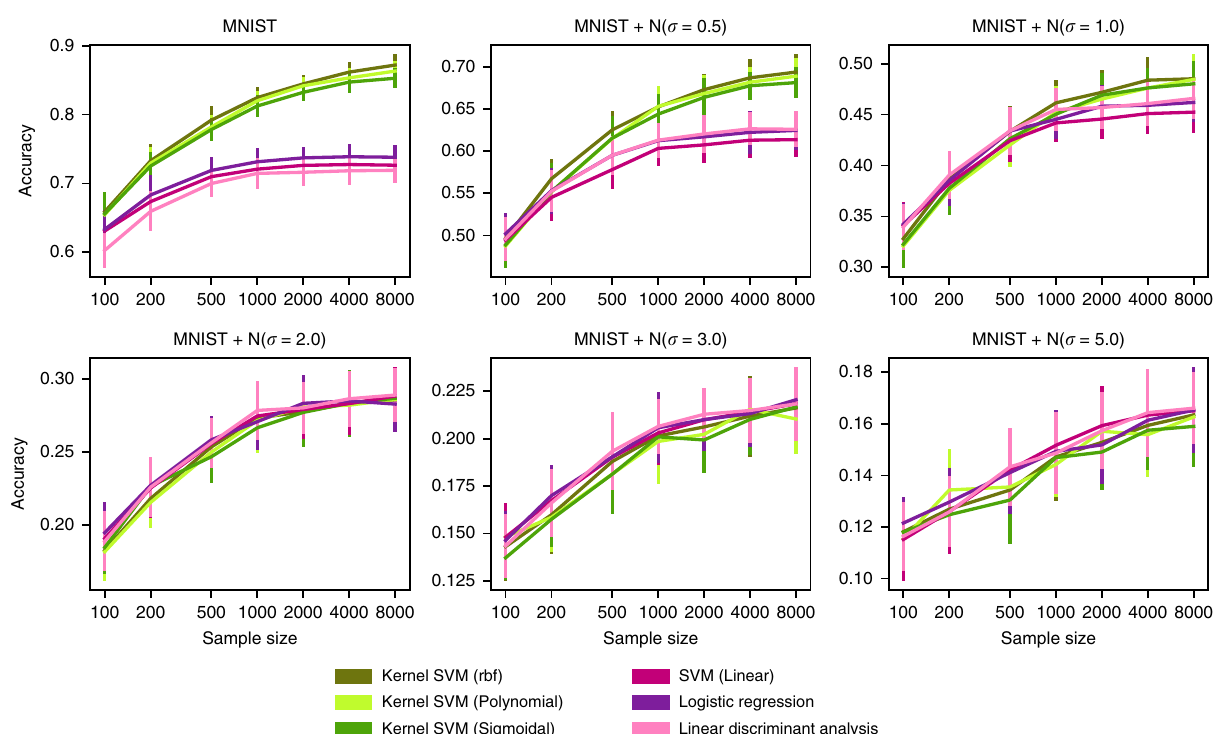
Fig. 6 Adding noise to MNIST images leads to scaling behavior similar to that of brain images. We extracted the eight leading principal components from the digit images (MNIST) and added Gaussian noise to each principal component. The principal component embeddings were then used as input variables for the models (see Supplementary Information for details) to predict the class label (i.e., digits). Increasing the amount of noise from σ = 0.5 up to σ = 5.0 entailed two effects: fi rst, gradual diminishing of the performance difference between nonlinear kernel models and linear models. Second, the increasing level of noise in the images reduced the extent to which prediction performance saturated with increasing sample size. At σ = 5.0, the sample complexity curves of MNIST data followed the same pattern as we observed on brain images (Fig. 2): kernel and linear models performed indistinguishably, and prediction performance did not visibly saturate. Our quantitative fi ndings invite the tentative speculation that MRI brain-imaging data may be too noisy to allow capturing nonlinear relationships for phenotype prediction at currently available sample sizes. Error bars = mean ± 1 SD across 20 cross-validation iterations (all panels).